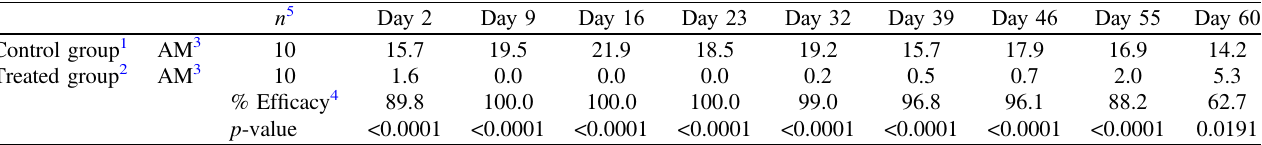
Table 1. Rhipicephalus sanguineus , mean live tick counts per group and ef fi cacy